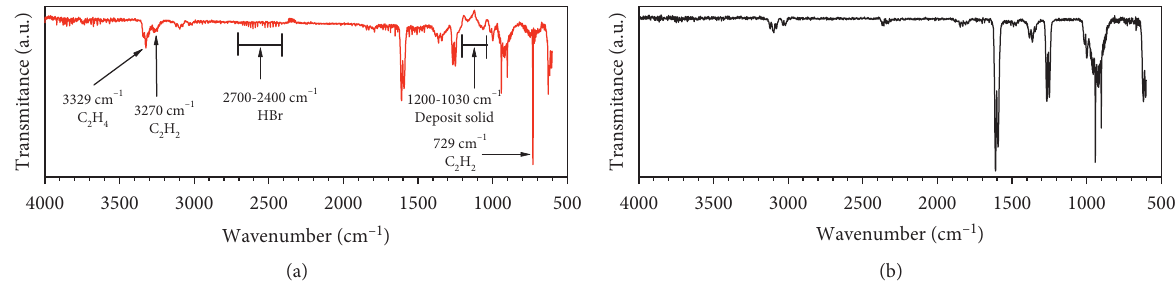
Figure 2: (a) FTIR spectrum of a 2.5 hPa of VBr pure sample in a gaseous state, recorded between 600cm − 1 and 4,000 cm − 1 . (b) FTIR spectrum after being irradiated with more than 600 infrared pulses.